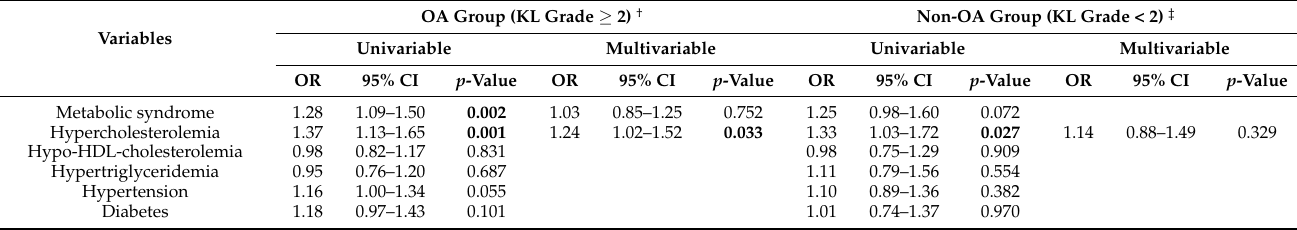
Table 2. Results of multivariable ordinal logistic regression analysis for knee pain (numeric rating scale) in the two subgroups divided according to the presence of radiographic